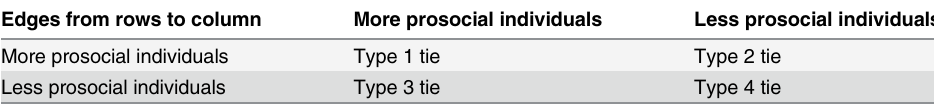
Edges are directed and from rows to column. For example, tie type 2 includes the ties from more prosocial individuals to less prosocial ones. When our hypothesized form of assortment occurs, the number of tie type 1 should be more frequent than other types of